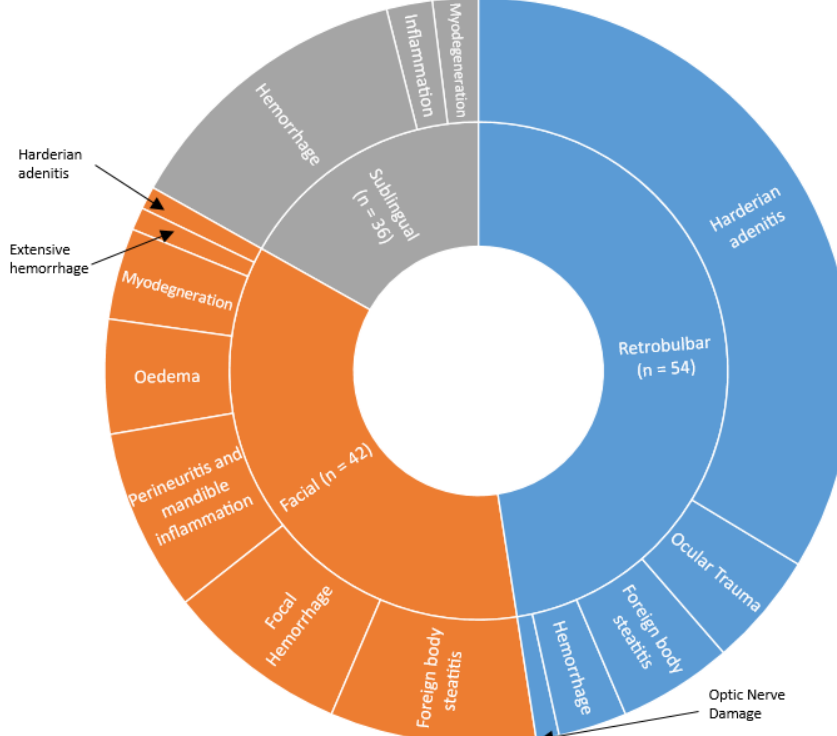
Figure 3. Histological characteristics observed in studies comparing large-volume sample sites. Size of slice represents relative incidence. Difference in reporting prevented assimilation of all findings. Compiled from [1,4,29,32,38]. Note that animals may have demonstrated more than one histological finding. n represents the number of animals.